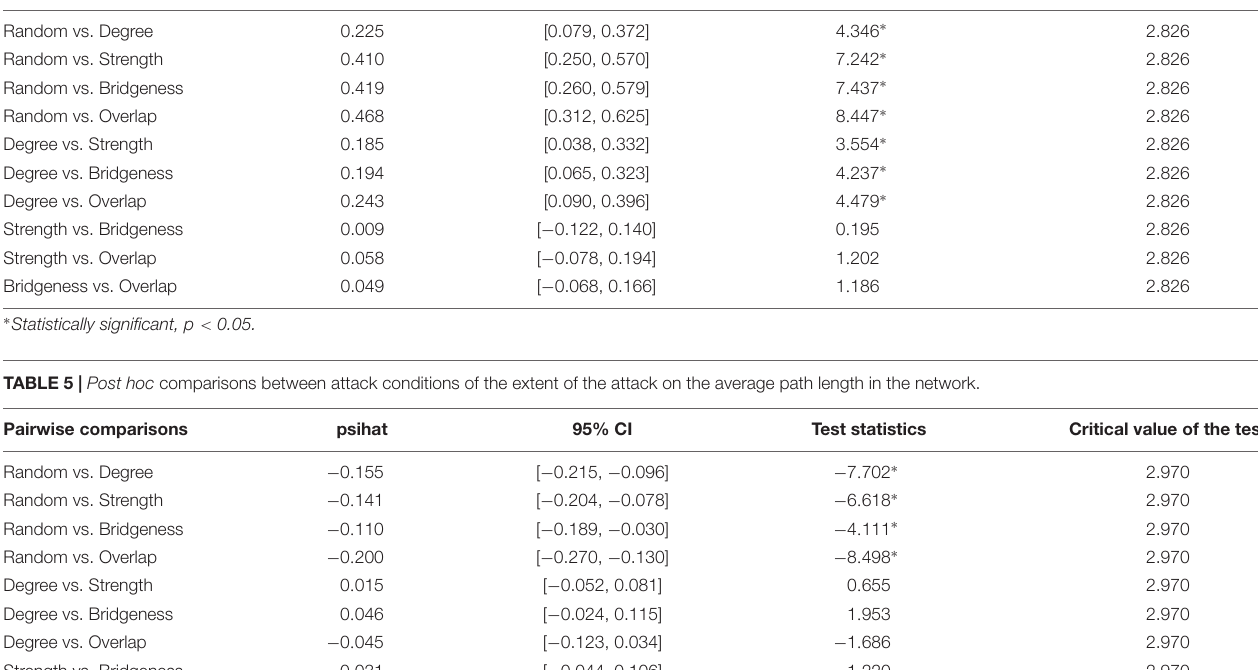
TABLE 4 | Post hoc comparisons between attack conditions of the magnitude of the impact on the average path length. Pairwise comparisons psihat 95% CI Test statistics Critical value of the test Random vs. Degree